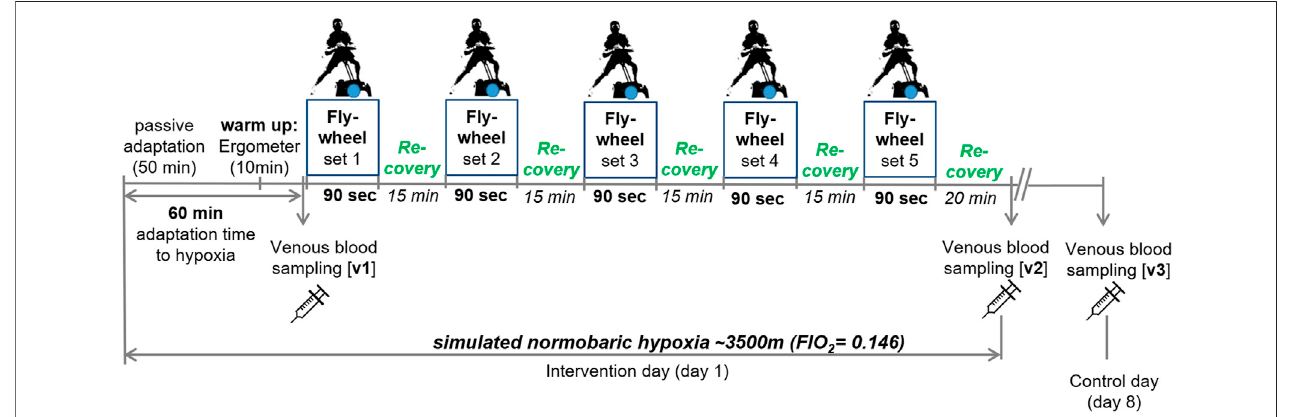
FIGURE 1 | Outline of the study design. v1-3, venous blood